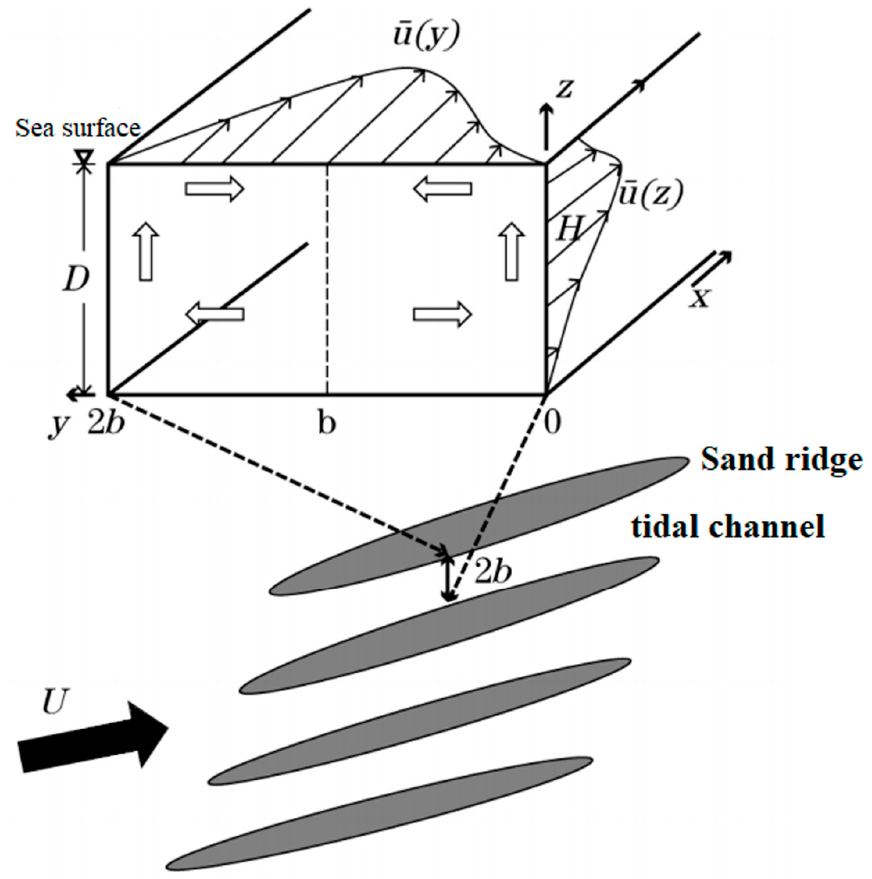
Figure 9. The physics model for secondary circulation (large hollow arrows) induced by a shear flow over parallel underwater topographic corrugation.